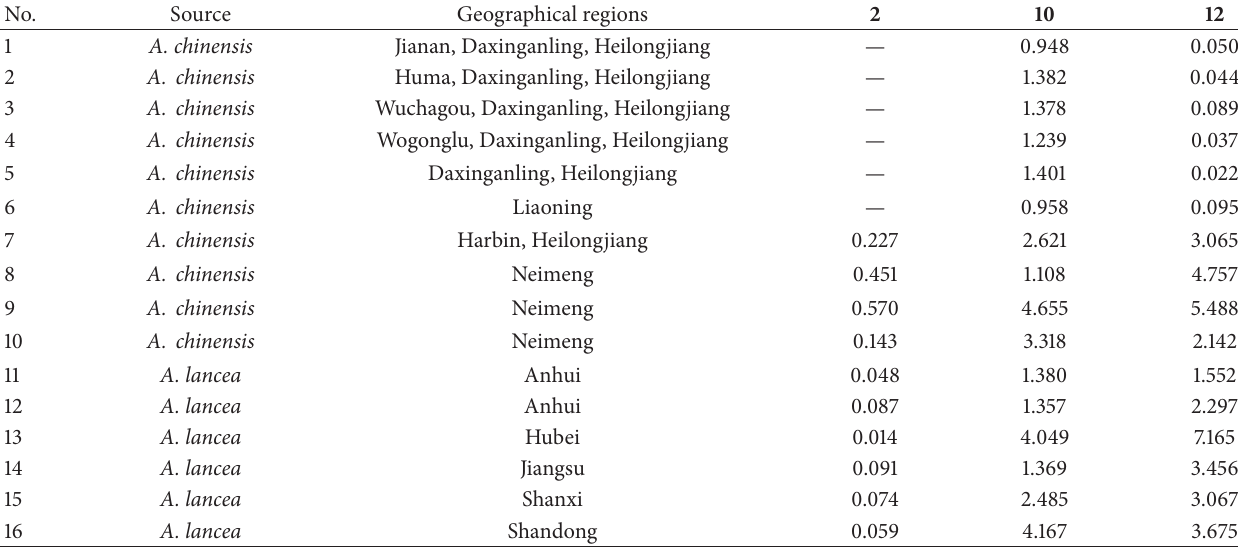
Table 4: The measurement results of marker compounds in A. chinensis and A. lancea (mg/g). The structures of 2 , 10 , and 12 can be seen in Figure 1.